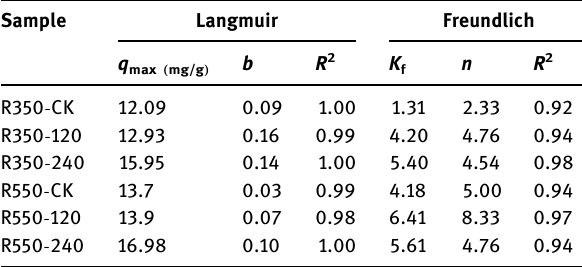
Table 5: The isothermal adsorption fi tting parameters of Cu ( II ) by biochars after di ff erent time in the soil Sample Langmuir